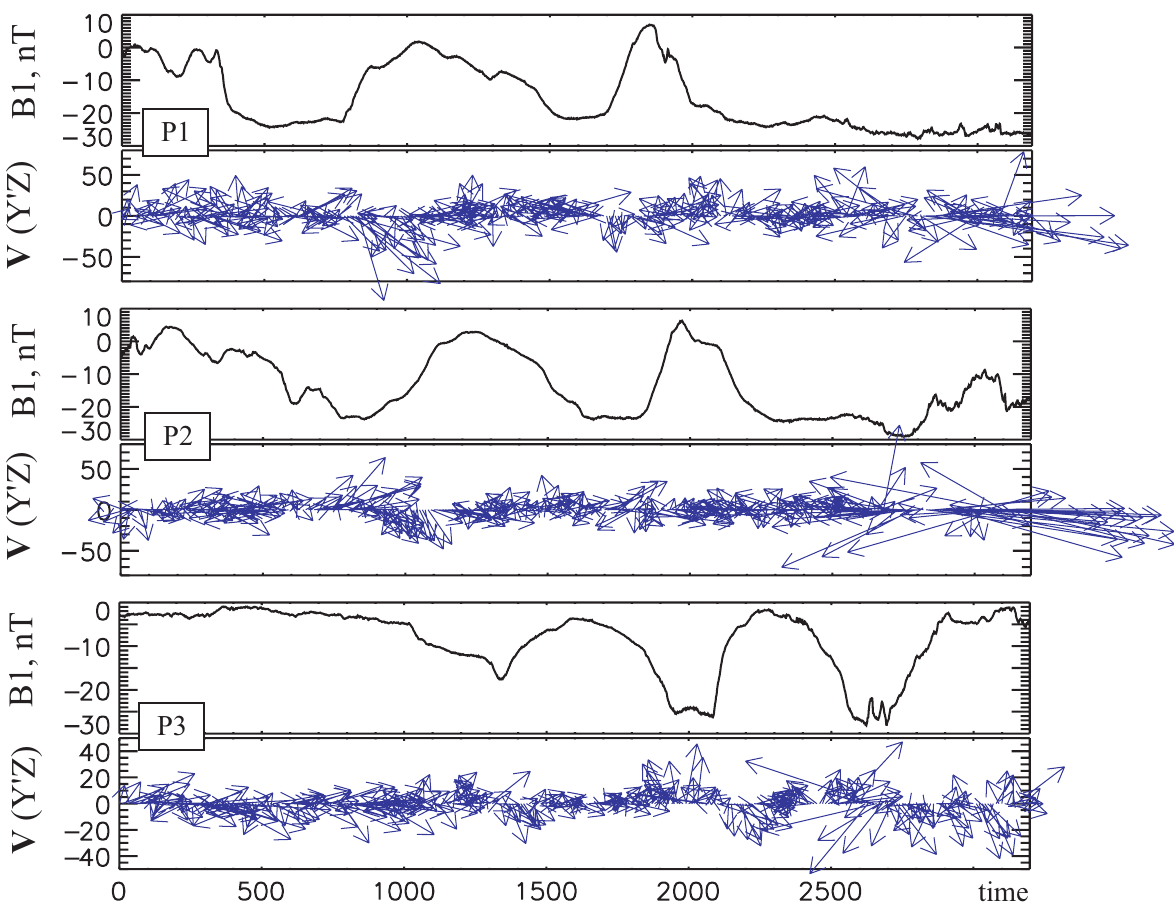
Fig. 6. Maximum variance component of the magnetic field ( B 1 ) and projections of plasma bulk velocity onto the plane perpendicular to B 1 ( Y 0 Z ) versus time (arbitrary